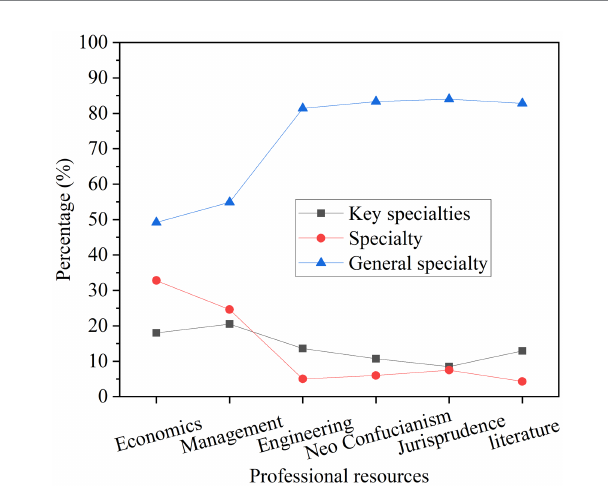
FIGURE 9 Evaluation of recommendation effect of model educational resources.